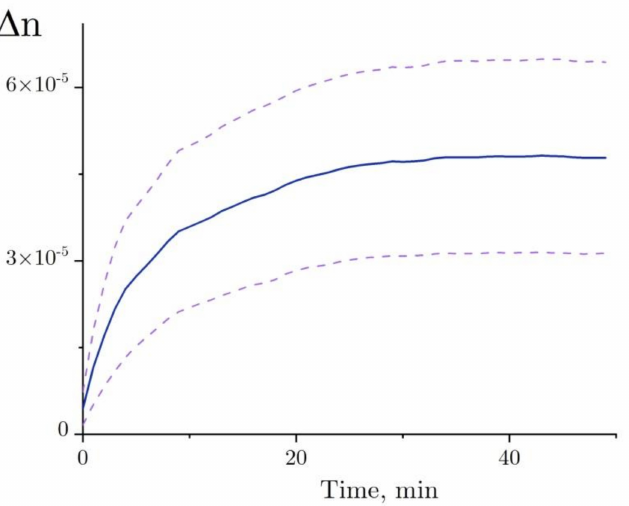
Figure 9. The change in the refractive index of the lysozyme solution (4 mg/mL) during denaturation in 50 mM Tris-HCl buffer (pH = 8.0) with the addition of 6 M GdnHCl and 30 mM DTT at room temperature. The upper and lower dashed lines of the standard error of mean are calculated from six experiments. The figure is plotted using the results published in